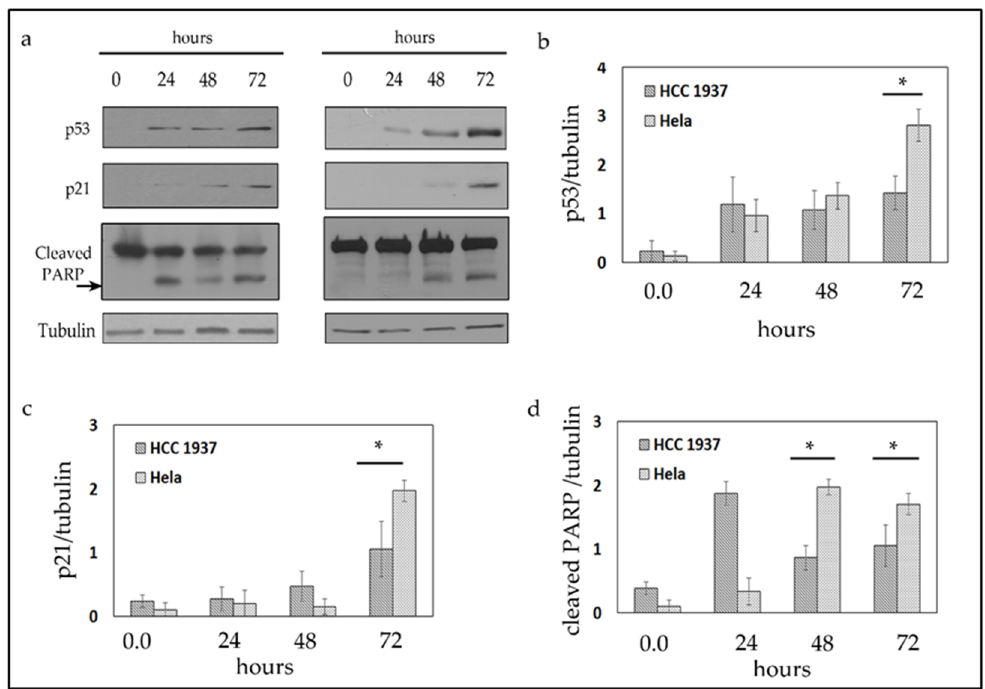
Figure 3. Compound 1 induces cell cycle arrest apoptosis in HCC1937 and HeLa cancer cells. ( a ) Western blots show protein from the indicated cancer cells treated as described in Figure 2 and analyzed with antibodies to p53, p21, and PARP. Tubulin was used as a loading control. ( b – d ) Graphs representing densitometric quantitation of the magnitude of proteins in ( a ), the asterisk signifies statistical significance by one-sided Student’s t -test (* p < 0.05).